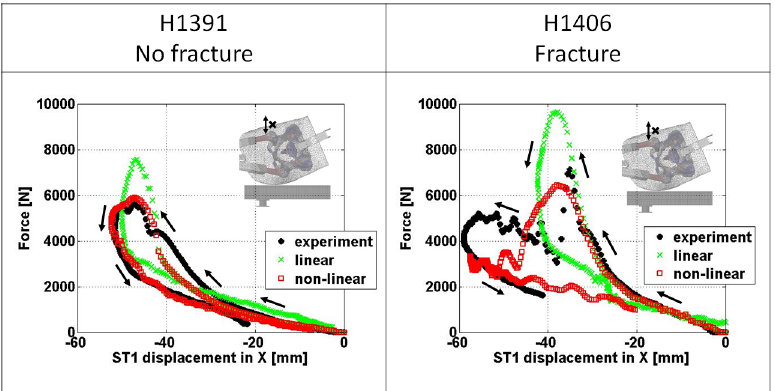
Fig 7. Comparison of impact force over displacement in x-direction of contralateral GT soft tissue marker (ST1) in the vertical direction between experimentally and FEM derived